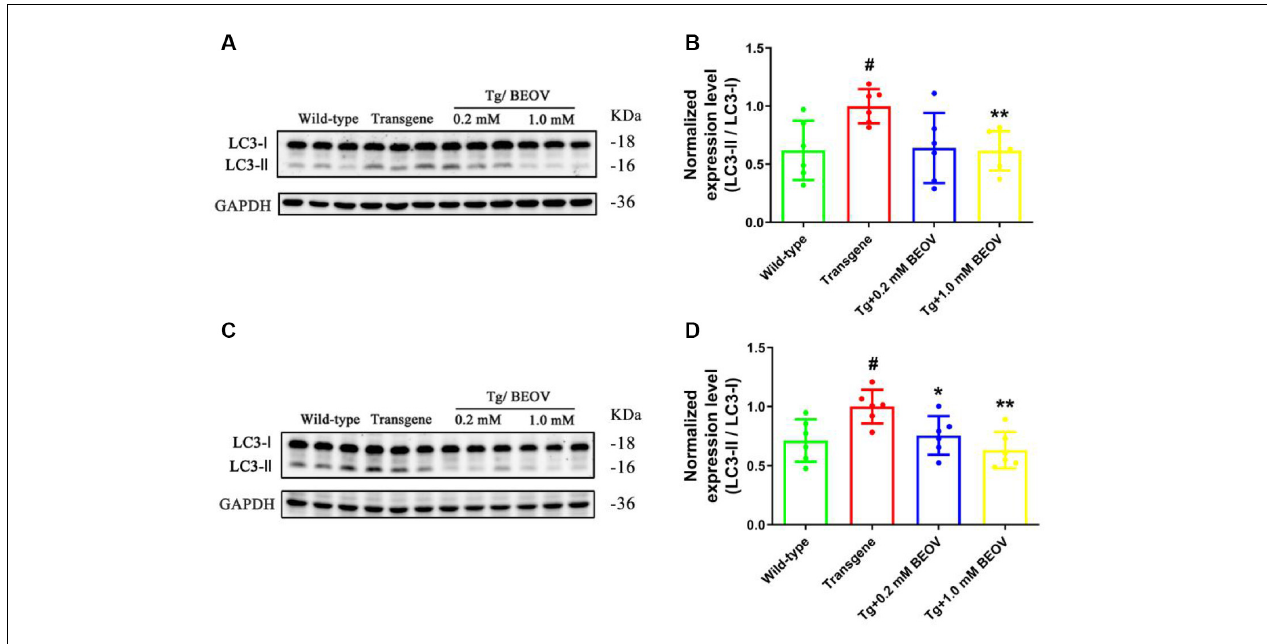
FIGURE 9 | The LC3-II/LC3-I ratio was decreased by BEOV in both the hippocampus and cortex of APPSwe/PS1dE9 mice. (A,C) Western blotting analyses of the LC3-I and LC3-II levels in the hippocampus and cortex of WT, APPSwe/PS1dE9, and BEOV-treated APPSwe/PS1dE9 mice. (B,D) Semi-quantification of the relative ratio of LC3-II/LC3-I in mouse hippocampus and cortex. Quantitative results were normalized against the levels of GAPDH. # WT group vs. AD group; *AD + BEOV group vs. AD group. n = 6, three females and three males; # P < 0.05, * P < 0.05 and ** P < 0.01,